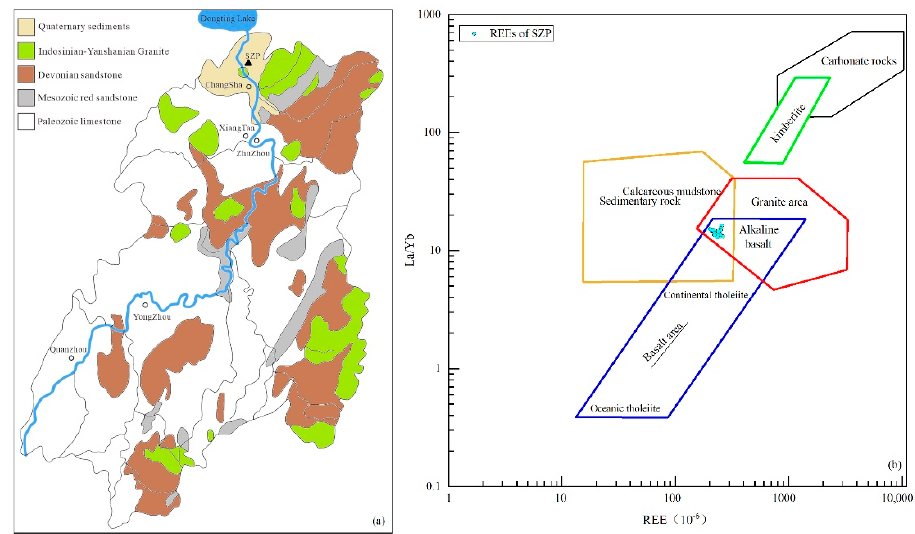
Figure 8. ( a ): Geological background tectonic map of the lower reaches of Xiangjiang River, adapted from[54]. ( b ): Distribution of samples on La/Yb −∑ REE diagram [100].